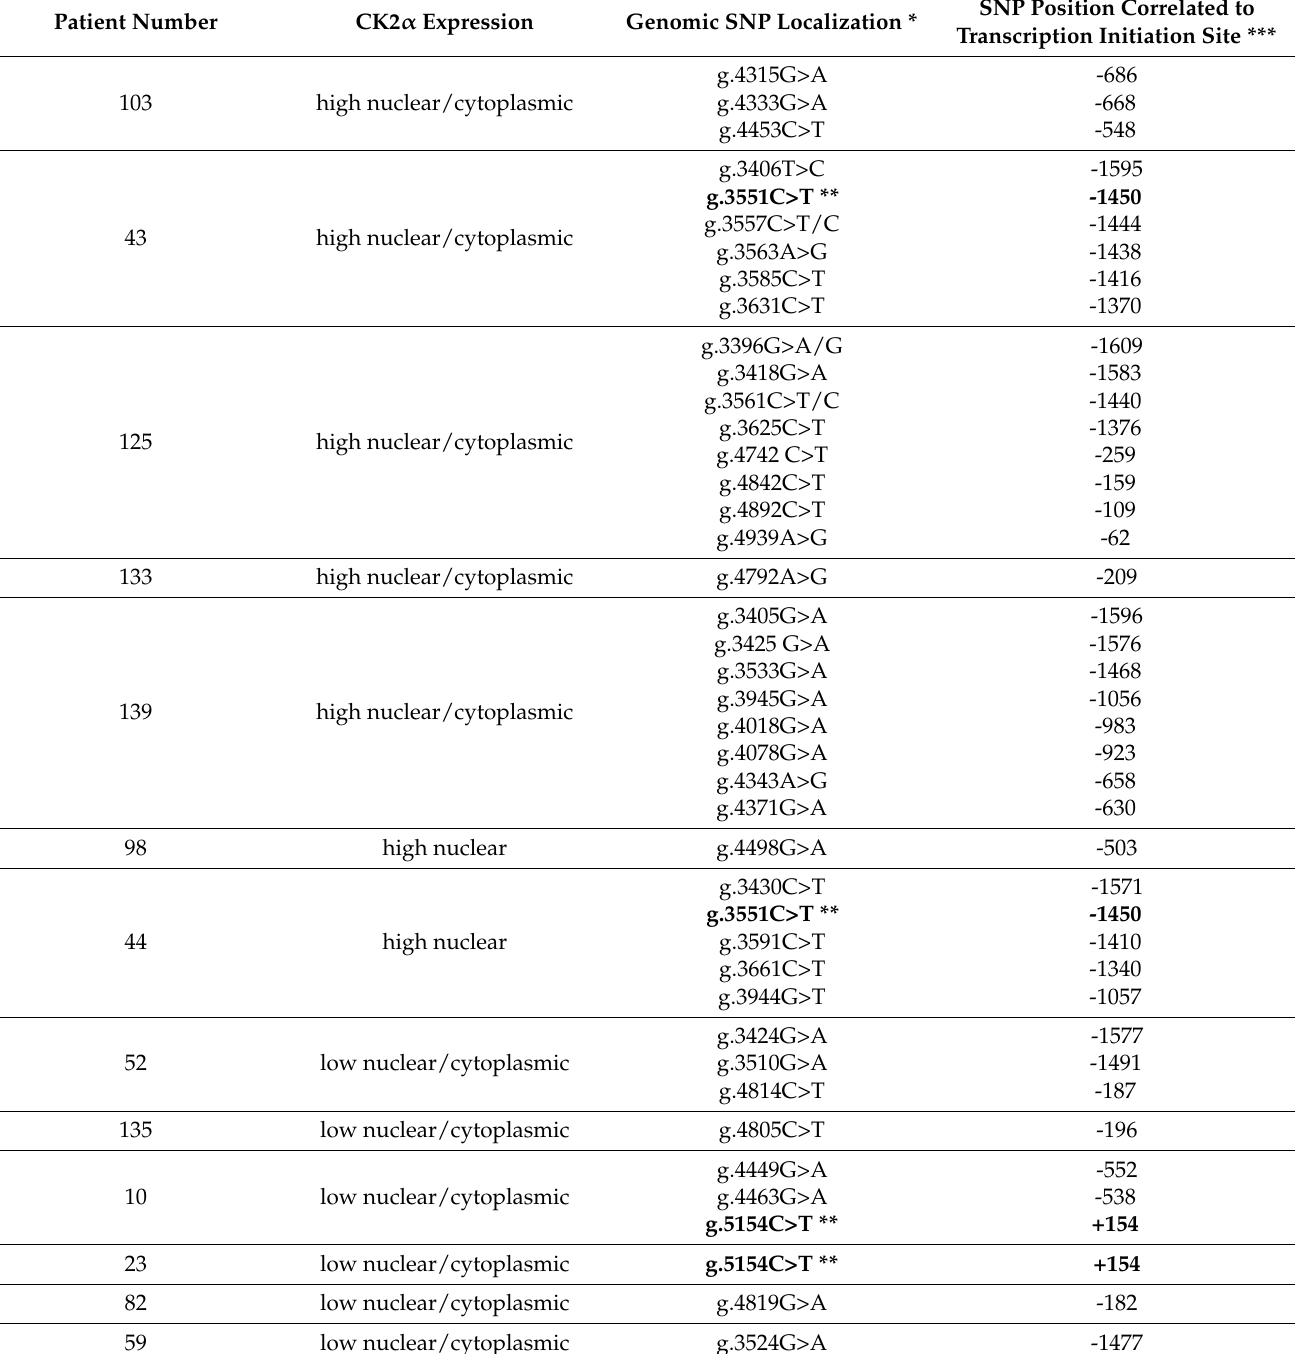
Because of the weak quality of the FFPE DNA, we used ten pairs of primers (Table 2) for the amplification of ten overlapping fragments and determined the amplified DNA fragments by sequencing. Interestingly, we found several SNPs in the analyzed CRC promoter areas (Table 4). The positions of the SNPs are shown in Figure S2. Although several SNPs have been already detected in the CK2 α core area (Figure S2), the detected single base pair alterations in our panel of patients are not described so far. Table 4. Detected somatic SNPs in CRC located in the CK2 α